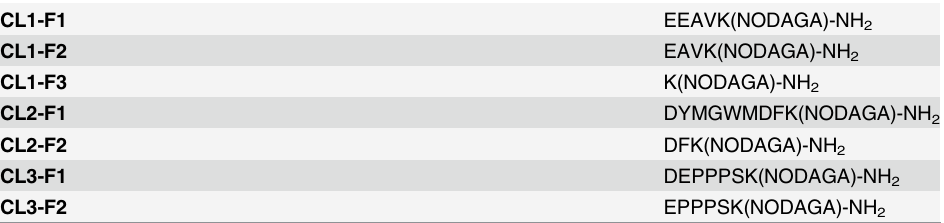
Table 1. Amino acid sequences of the peptide